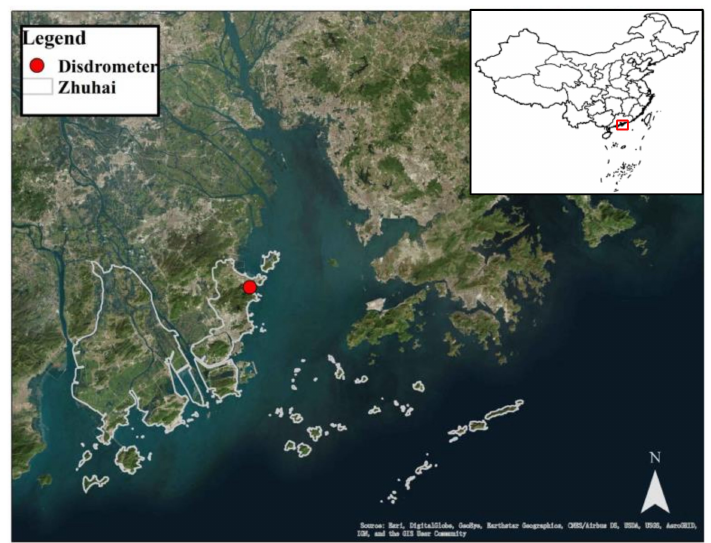
Figure 1. The map of Zhuhai. The red circle represents the disdrometer and the red rectangle is the rough location of Zhuhai in